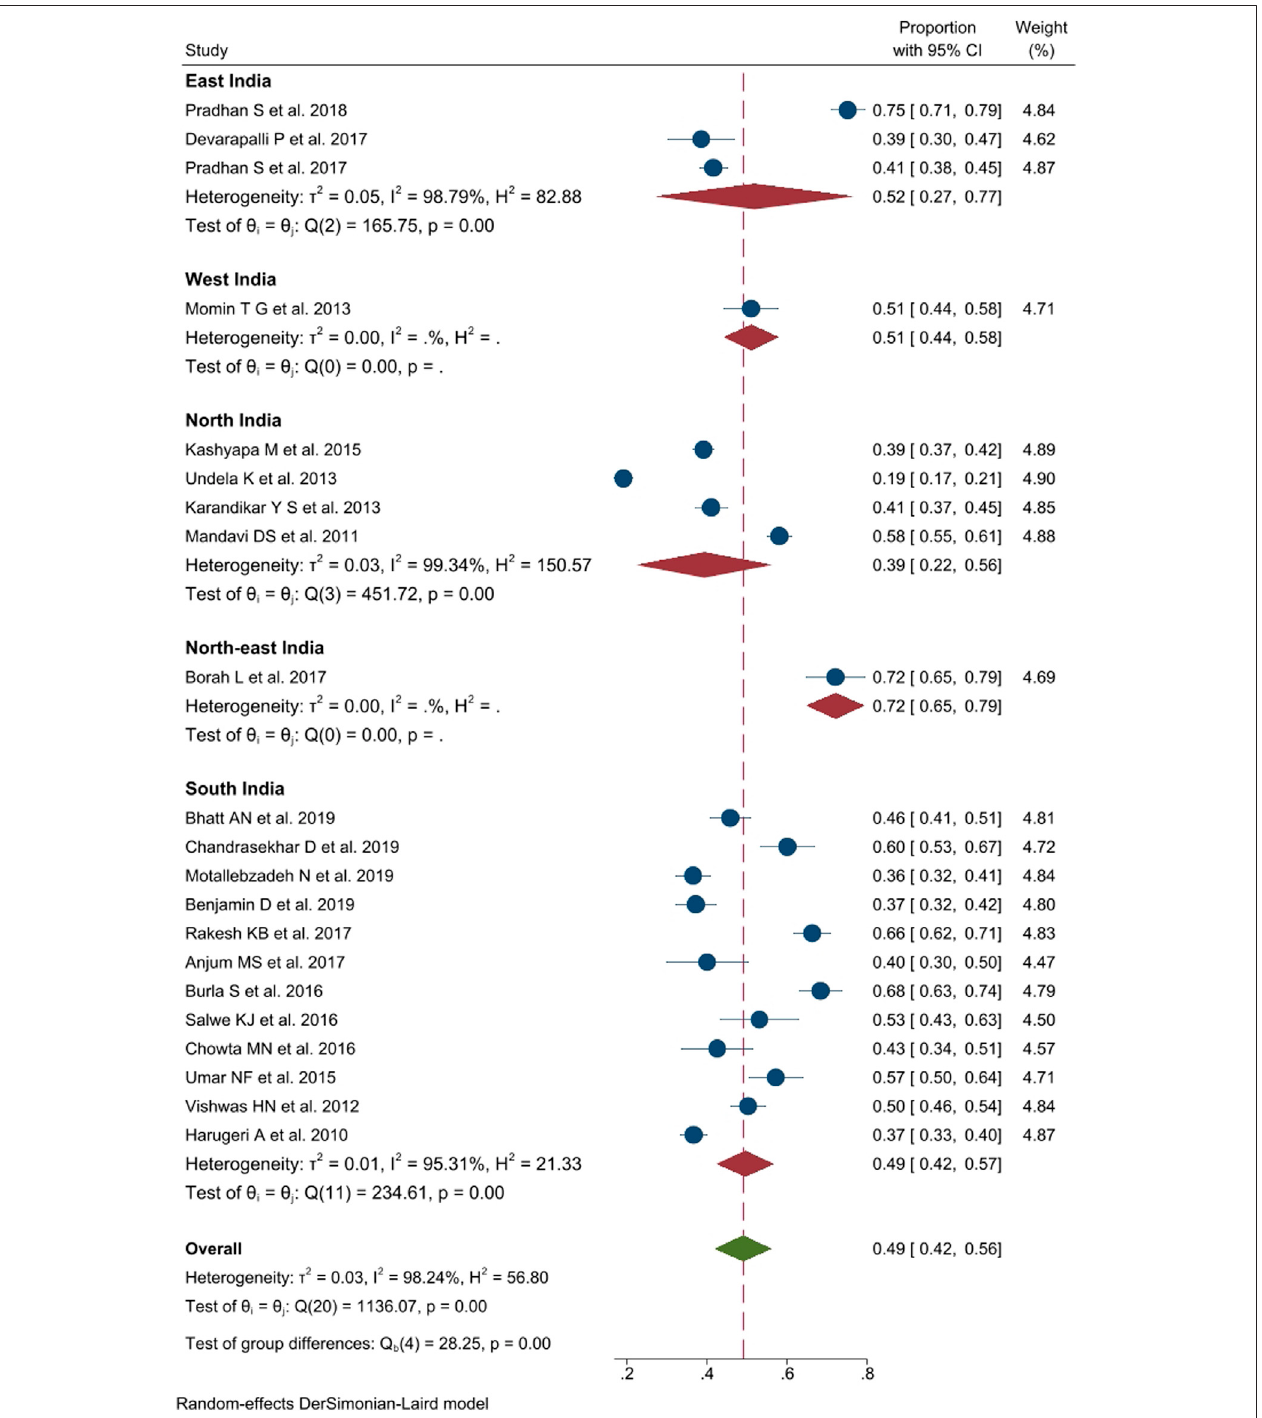
FIGURE 2 | Prevalence of polypharmacy use (5-9 medications) in older people across various geographic regions in India.